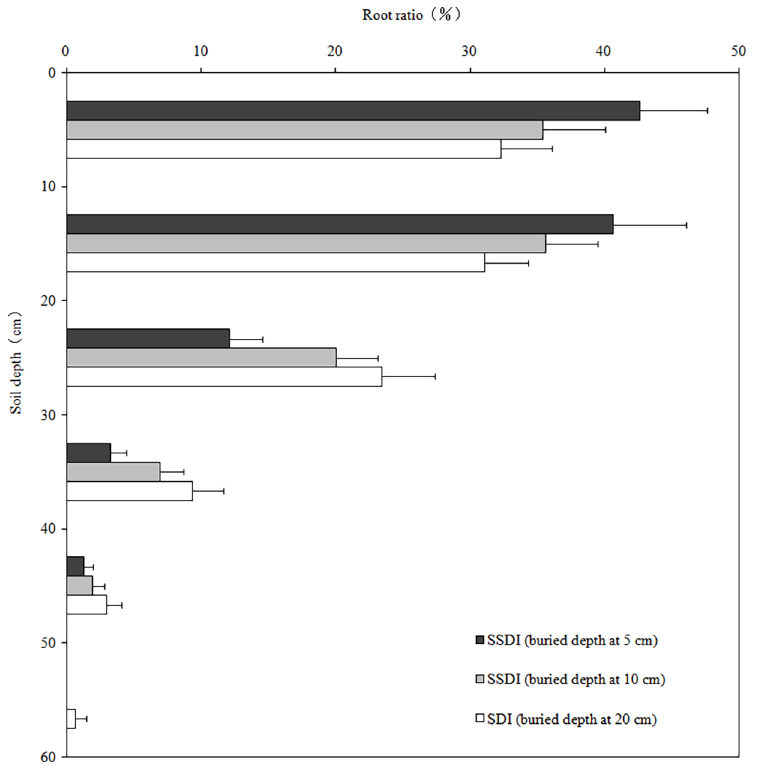
Fig 4. Root weight density ratio in different soil layers at flowering stage of